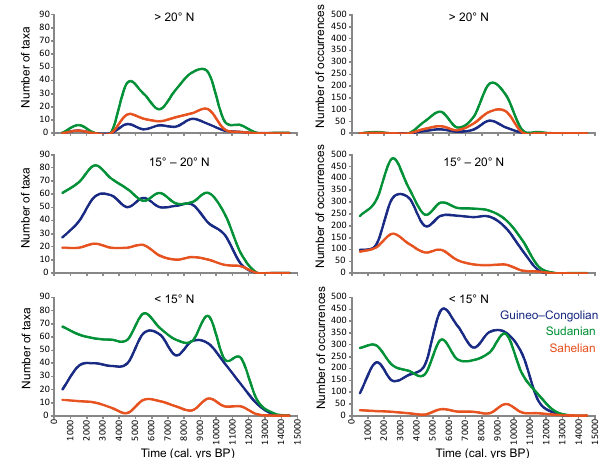
Fig. 3. Change in biodiversity within the Guineo–Congolian, Suda- nian, and Sahelian groups (including exclusive and non-exclusive taxa) as a function of time in the three latitudinal zones: < 15 ◦ N, 15–20 ◦ N, > 20 ◦ N, with the richness (number of taxa) on the left and their abundance (occurrences) on the